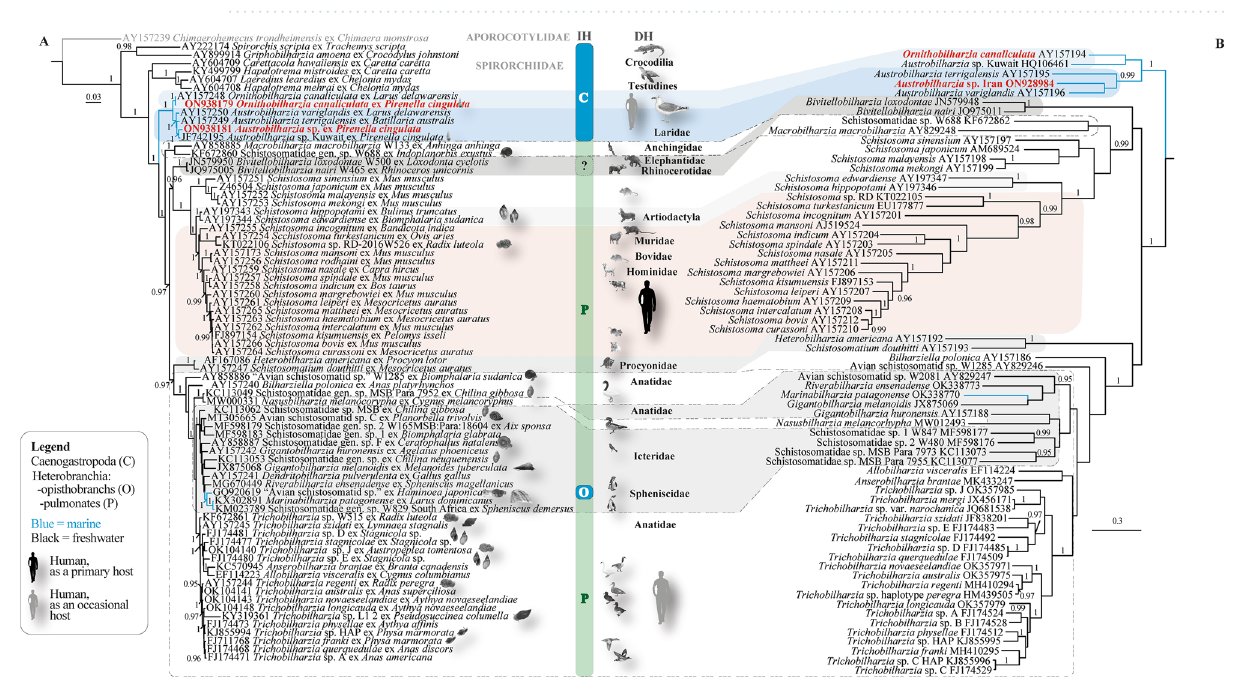
Figure 2. Bayesian analyses of the ( A ) 28S rDNA and ( B ) cox 1 datasets constructed using MrBayes v. 3.2.3 under the GTR + I + Г model of sequence evolution. Analyses were run for 10,000,000 generation and 25% discarded as "burn-in". Posterior probability values are given above the branches; values. Nodes with < 0.95 posterior probability support have been collapsed. Branch length scale-bar indicates number of substitutions per site. Newly-generated sequences are indicated in colour indicated red and bold. Hosts of origin of individual sequences are indicated after the specimen’s host name. Branches in blue indicate schistosomes with marine life- cycle. Shaded areas and taxa outlined with doted lines reflect on the current taxonomic framework of the family and also given on the